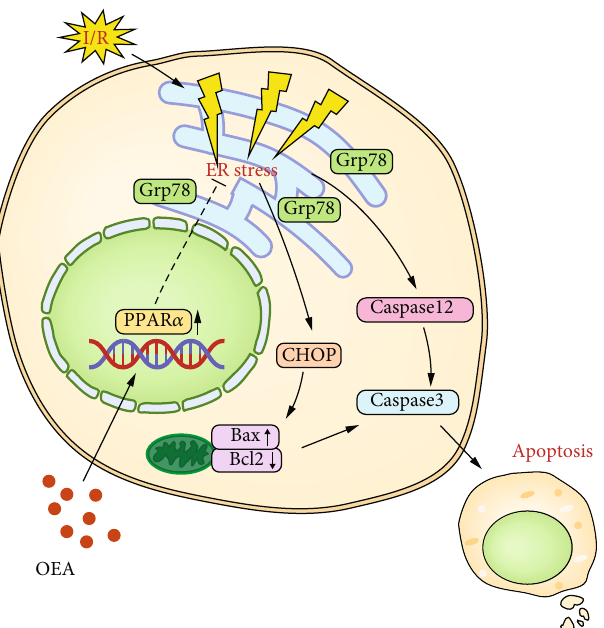
Figure 7: Mechanism of OEA alleviating liver I/R injury. OEA upregulates PPAR α expression, promotes the nuclear translation of PPAR α , inhibits ER stress-associated apoptosis, and alleviates liver I/R